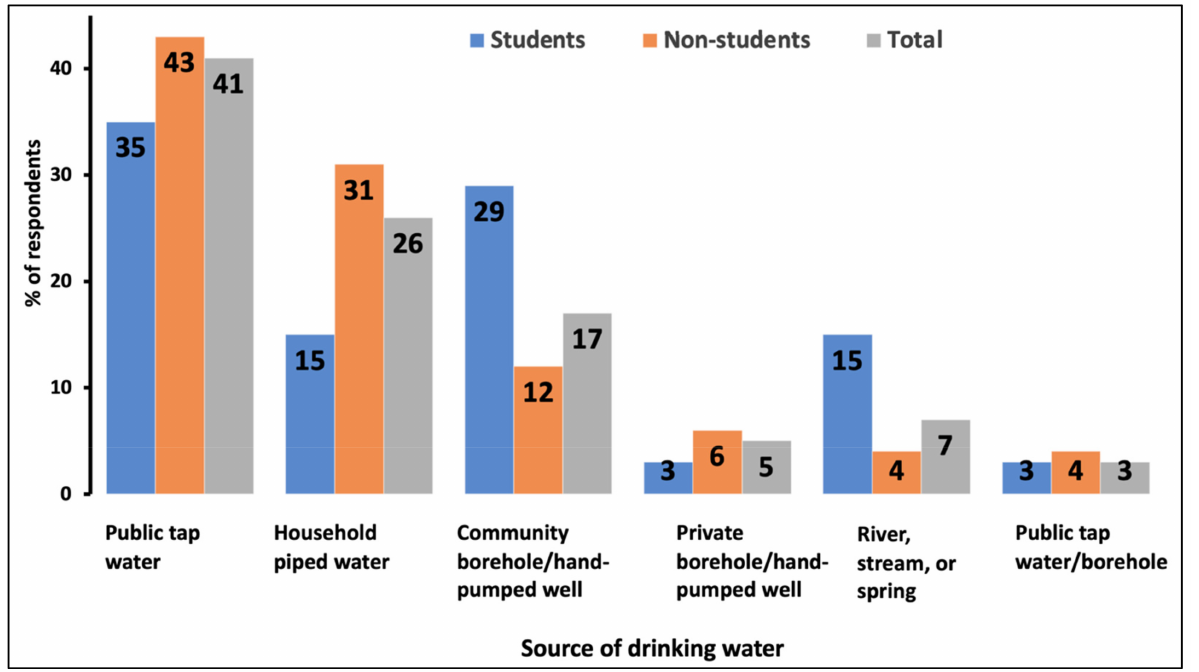
Figure 2. The percentage of respondents and their use of drinking water sources in the Makindu– Kibwezi area of Makueni